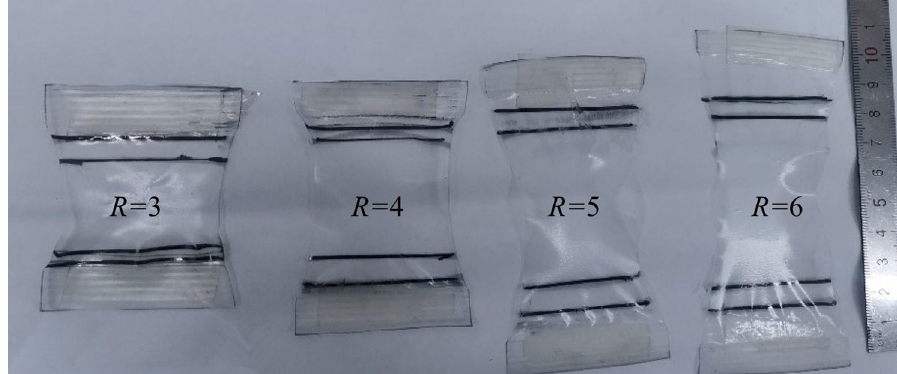
Figure 2: Images of stretched fi lms with di ff erent elongation